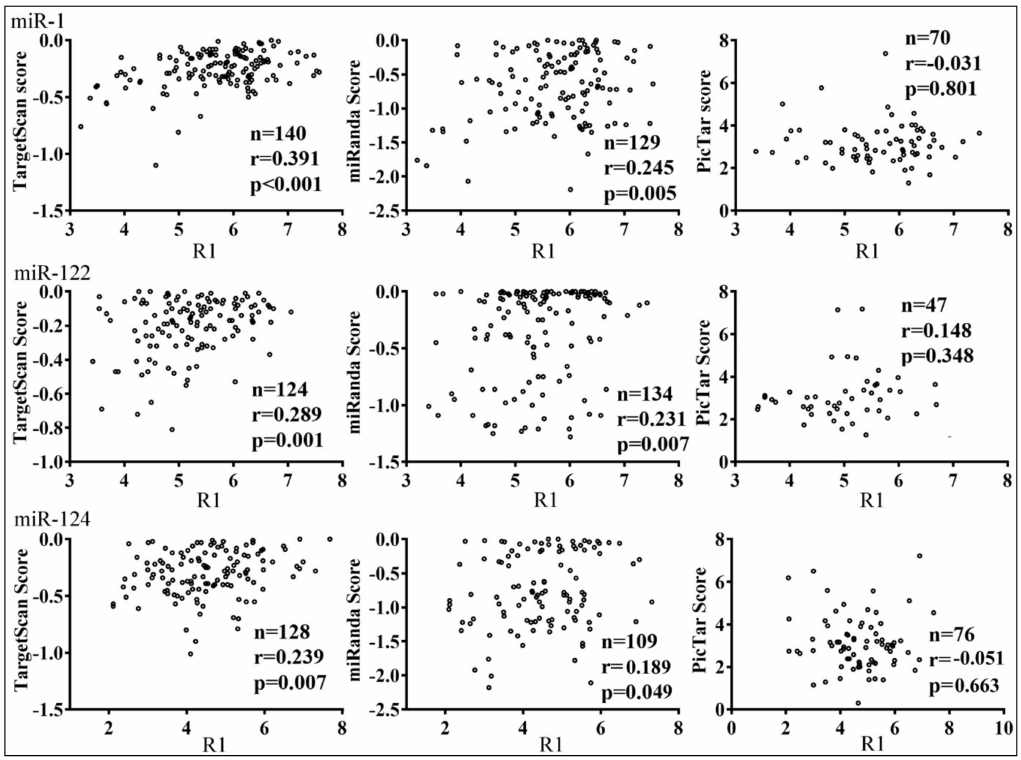
Figure 5. Correlations between miRNA reporter inhibition indexes (R1, x -axes) and the scores of TargetScan, miRanda, and PicTar ( y -axes). Little circles represent individual confirmed targets. The sample size ( n ), correlation coe ffi cients (r), and p -values are